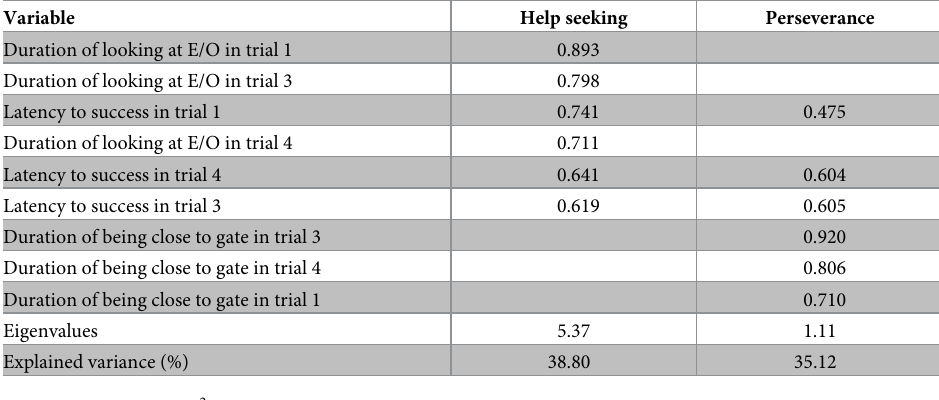
Table 9. Components derived from PCA on the variables measured in the detour